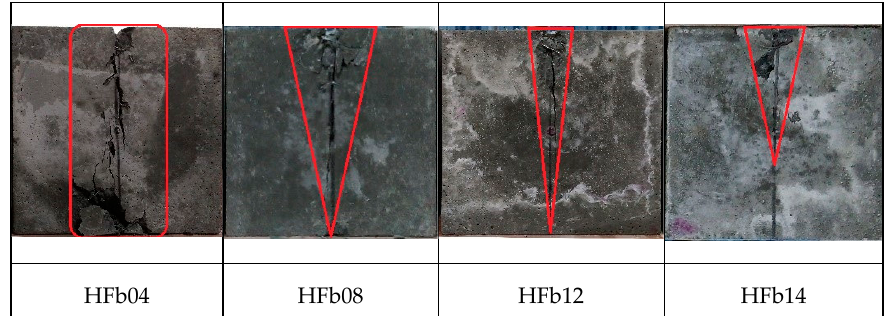
Figure 4. Failure patterns of splitting tensile specimens with the crushed zone emphasized by red lines.